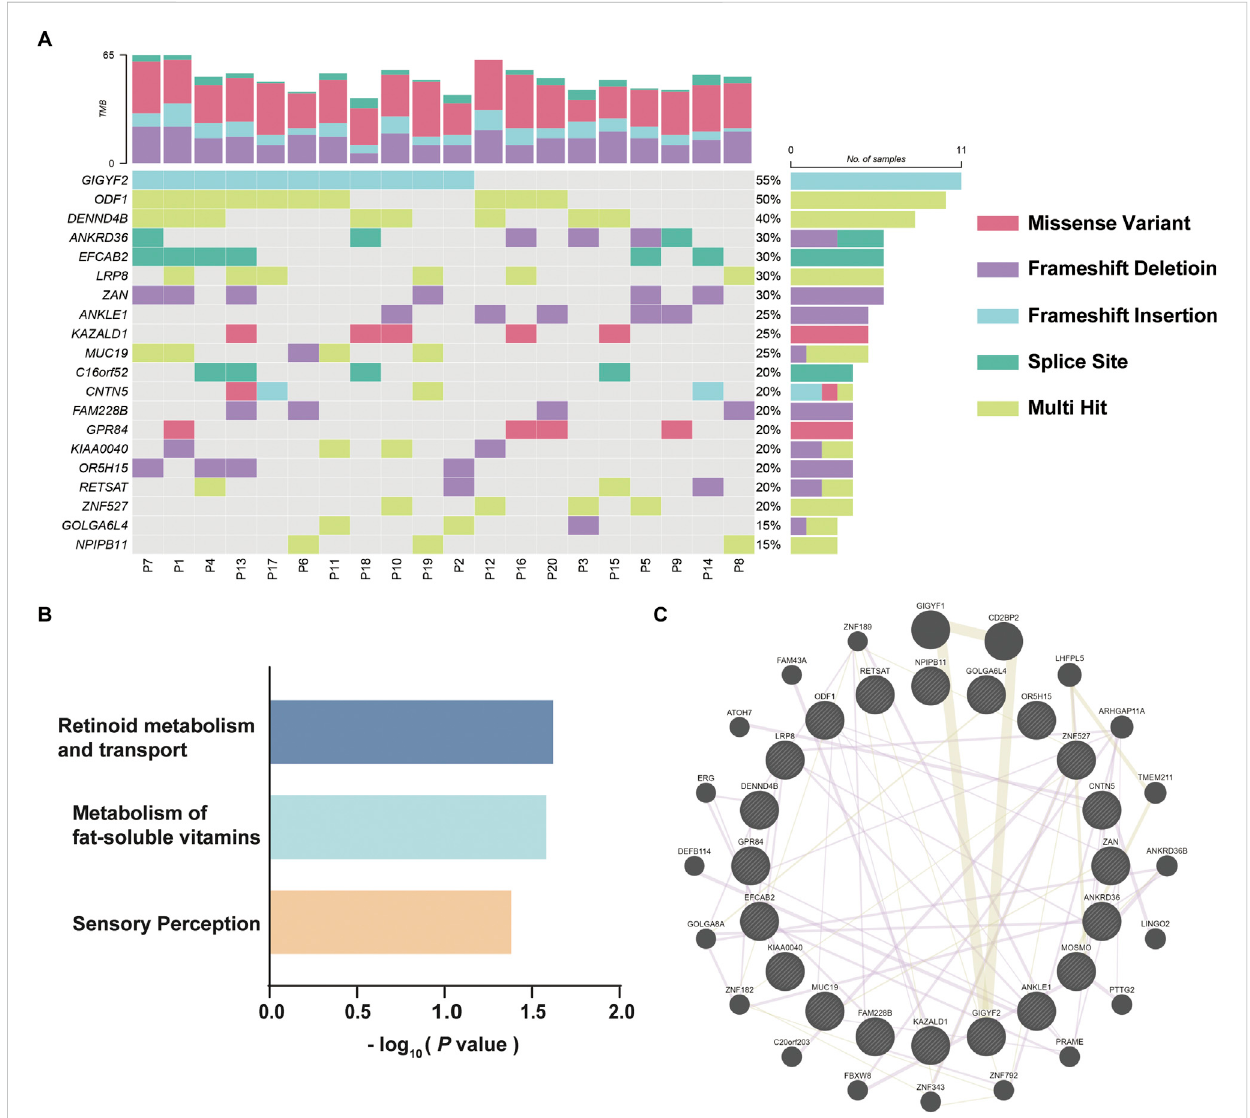
FIGURE 3 Top 20 mutated genes in DOR. (A) The variant characteristics of top 20 mutated genes in each patient. The twenty DOR patients included for WES were represented by “ P01 ” - “ P20 ” . (B) Enrichment analysis of top 20 mutated genes using Reactome pathways. (C) Protein-protein interactions of mutated genes identi fi ed using GENEMANIA